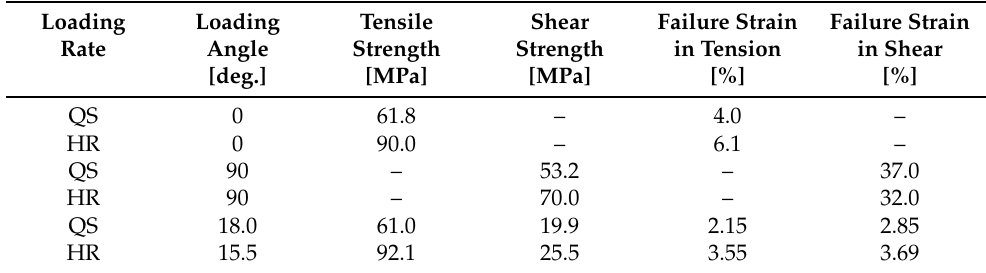
Table 3. Experimentally estimated tensile and torsional (shear) strengths of butt-joint specimens studied in